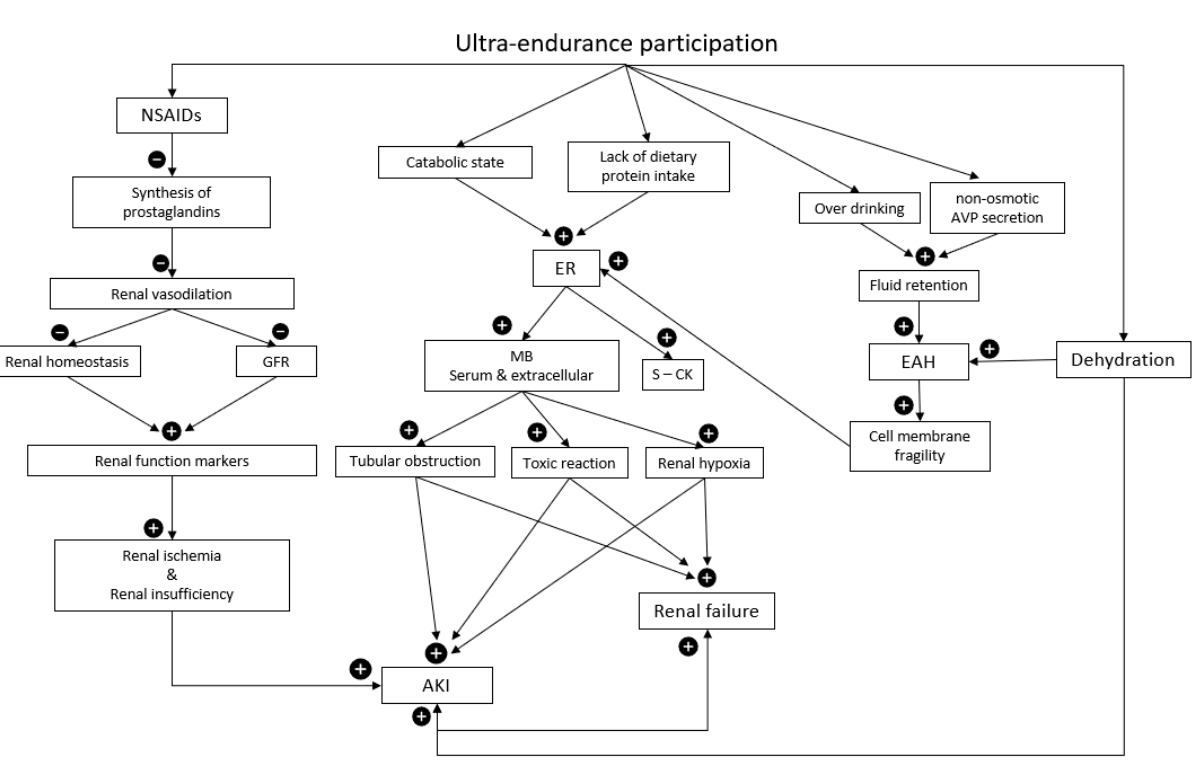
Figure 3. Multiple pathologies and mechanisms promoting acute kidney injury (AKI) in ultra ‐ en ‐ durance athletes. Non ‐ steroidal anti ‐ inflammortory drugs (NSAIDs), glomerular filtration rate (GFR), exertional rhabdomyolysis (ER), myoglobin (MB), serum creatine kinase (S ‐ CK), arginine vasopressin (AVP), exercise ‐ associated hyponatremia (EAH), = increase, = decrease. Compared to marathon (42 km) and trail runners (67 km), ultramarathon runners